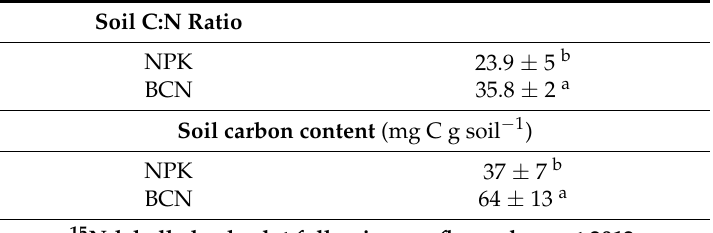
15 N-labelled sub-plot following sunflower harvest